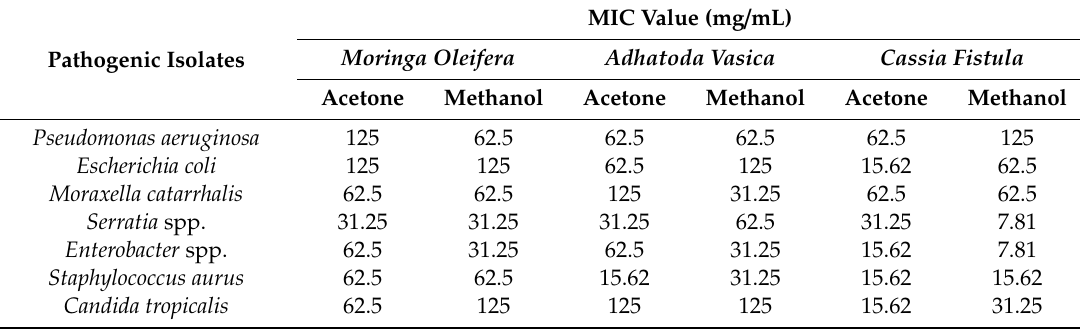
Table 6. MIC values of the selected plant extract against di ff erent